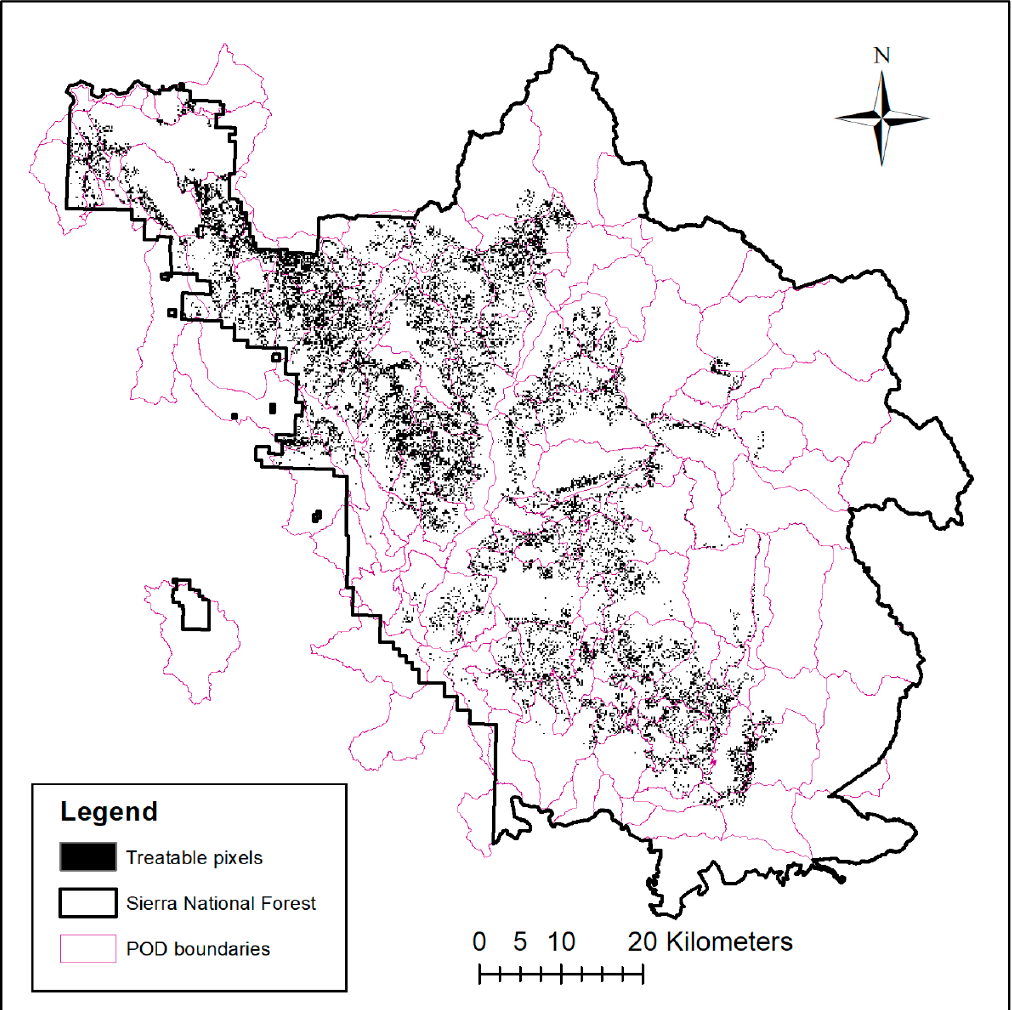
Figure 1. Sierra National Forest, POD boundaries, and feasible treatment locations. The treatment locations were determined by applying the constraint filters of [33] plus additional filters developed on the basis of economic viability (see Section 2.3). POD = potential wildland fire operations delineation, i.e., our unit of analysis for fuel treatment prioritization.